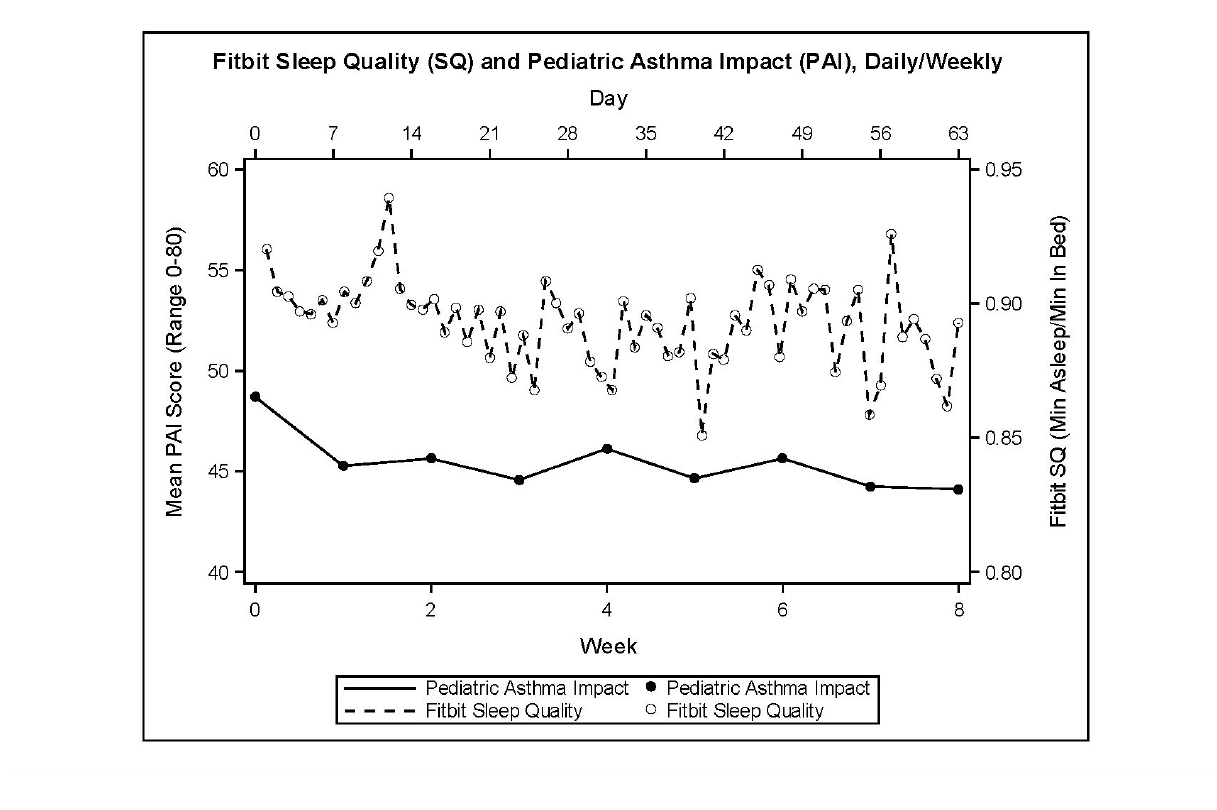
Figure 3. Fitbit sleep quality and pediatric asthma impact.